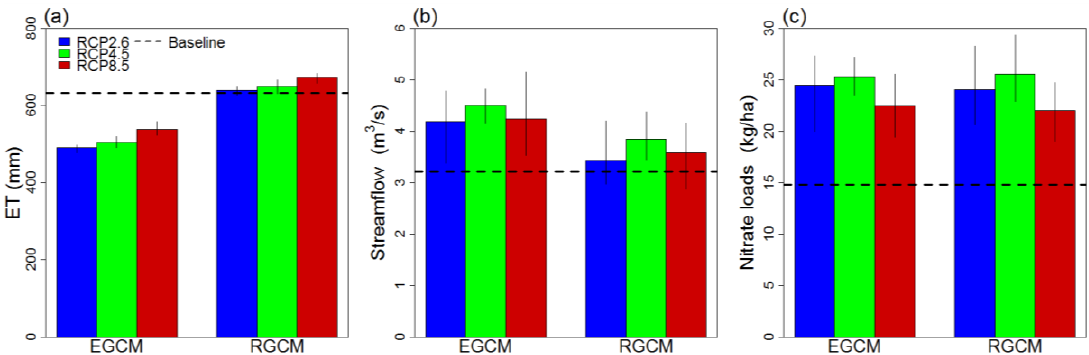
Figure 6. The annual average hydrologic variables predicted using EGCM and RGCM: ( a ) ET; ( b ) streamflow; and ( c ) nitrate loads.